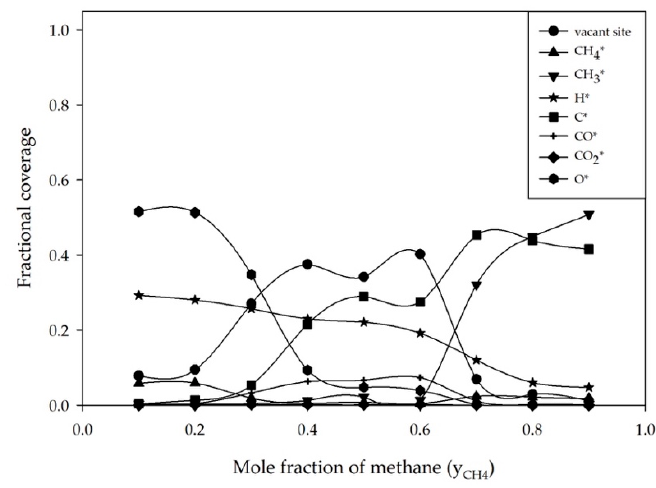
Figure 3. Fractional coverages as a function of the mole fraction of methane; T = 823 K and P = 1 bar. Catalysts 2019 , 9 , x FOR PEER REVIEW